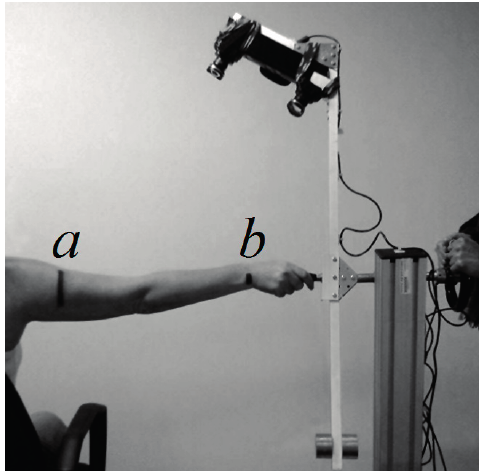
Figure 2. Measurement phase with SkanLab. ( a ) Level marking the 60% of the distance between the acromion of the shoulder and the olecranon of the ulna; ( b ) level marking the wrist crease distal to the styloid process (minimum wrist